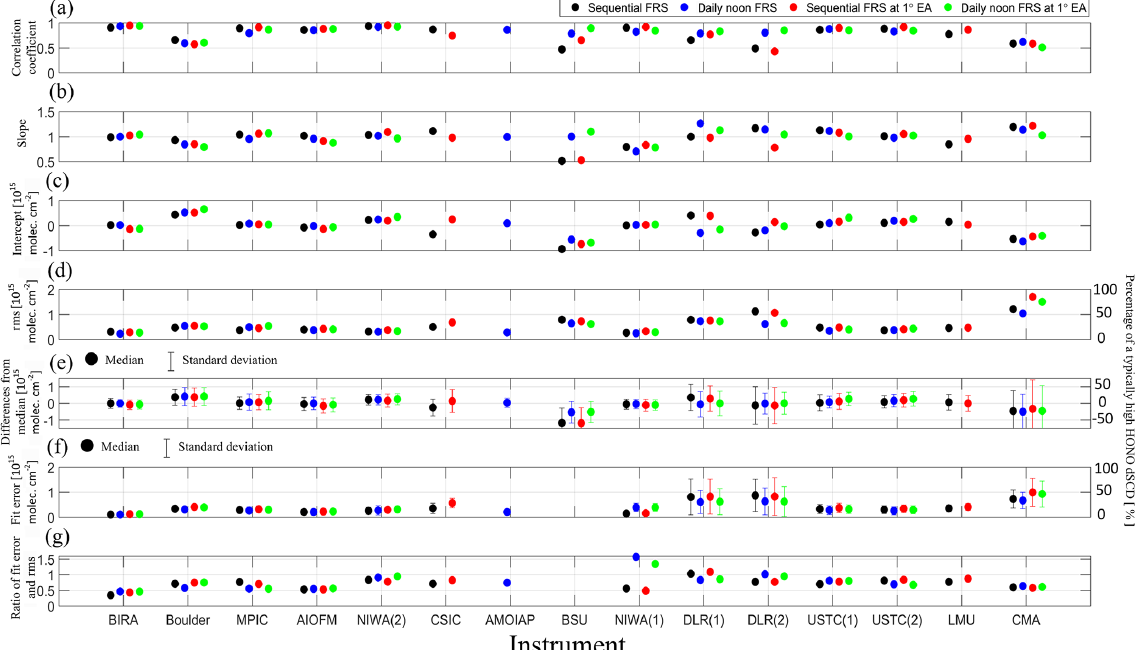
Figure 3. Correlation coefficients (a) , slopes (b) , intercepts (c) , and rms of the residuals (d) derived from the linear regressions versus the median values. The median differences and standard deviations derived from the comparison of the HONO delta SCDs from individual instruments and the median values of all instruments during the whole CINDI-2 campaign period are shown in (e) . In (f) the median values and the standard deviation of the DOAS fit error are shown. The y axis on the right-hand side of (d) , (e) , and (f) indicates percentages calculated by dividing the absolute errors by a typical high HONO delta SCD of 2 × 10 15 molec.cm − 2 . In (g) ratios of rms and DOAS fit errors are